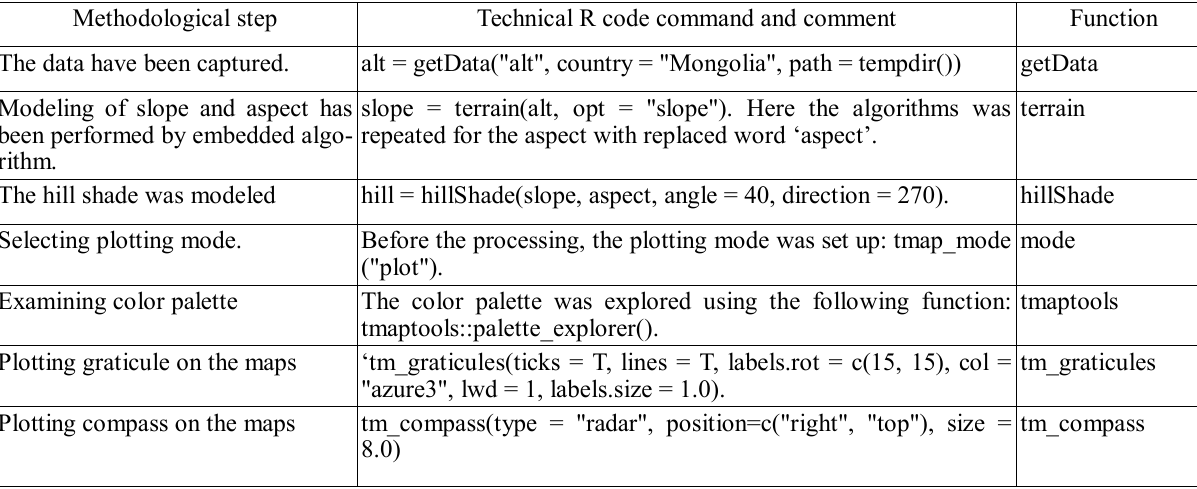
Table 2. Methodological workflow in R